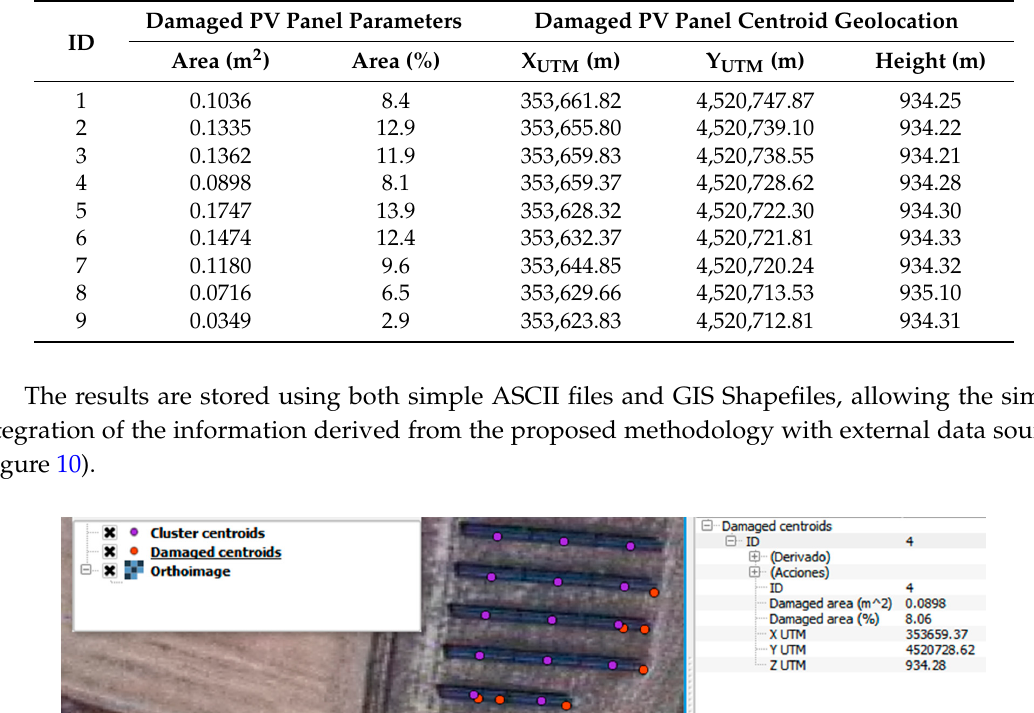
Figure 10. Result of the proposed methodology integrated with aerial orthophotography from a WMS (Web Map Service) using a GIS (Geographic Information System) client.